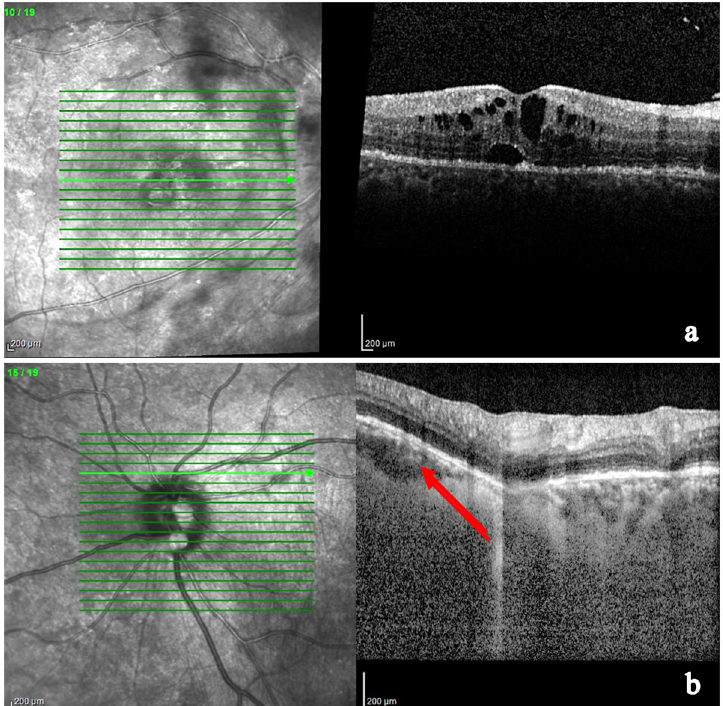
Figure 10. OCT showing chronic CME and a foveal serous detachment ( a ); OCT EDI showing deep choroid and a choroidal granuloma of the optic nerve head (arrow) ( b ).